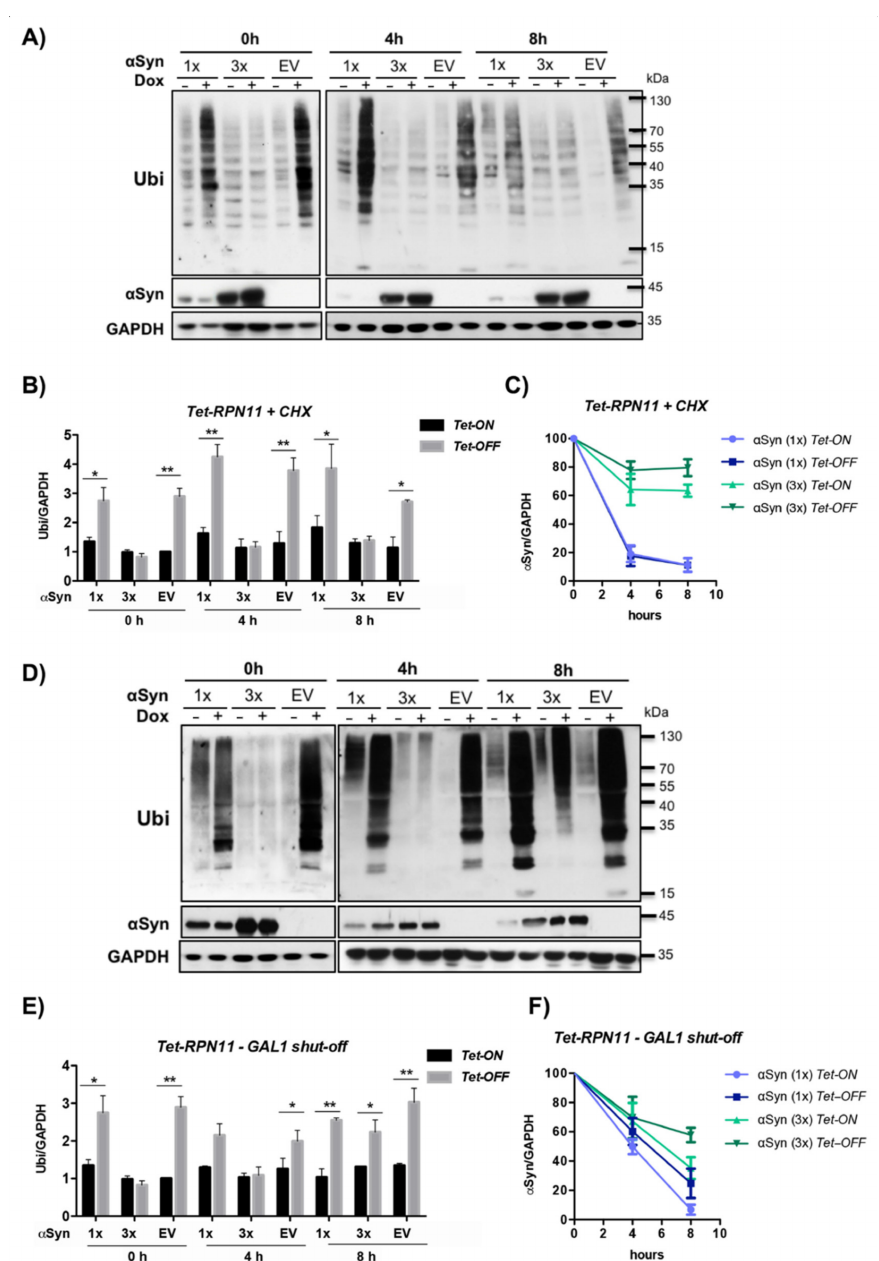
Figure 8. High level of α Syn decreases the pool of ubiquitinated substrates upon downregulation of Tet-RPN11 . ( A ) Western blot analysis of Tet-RPN11 mutant strains treated with cycloheximide. Strains harboring one (1 × ) or three (3 × ) gene copies of α Syn or an empty vector (EV) as a control were grown overnight in a galactose medium to induce α Syn expression. The Tet promoter was downregulated by addition of 10 µ g/mL doxycycline to the growth medium. The next day, cells were treated with 50 µ g/mL cycloheximide to stop de novo protein synthesis. Immunoblotting analysis was performed at the indicated time points after addition of cycloheximide with ubiquitin (Ubi) or α Syn antibodies. GAPDH was used as a loading control. ( B ) Densitometric analysis of the immunodetection of the ubiquitin conjugates relative to the GAPDH loading control. The ubiquitin/GAPDH ratio was normalized to the ratio of EV ( Tet -ON) at 0 h. The significance of the differences was calculated with a t -test (*, p < 0.05; **, p < 0.01, n = 3). ( C ) Densitometric analysis of the immunodetection of α Syn relative to the GAPDH loading control. The α Syn/GAPDH band ratio was normalized to the corresponding ratio at 0 h and presented as percentage. Values represent the mean ± SEM of three independent experiments. ( D ) Recovery of the depleted ubiquitin pool is accompanied by α